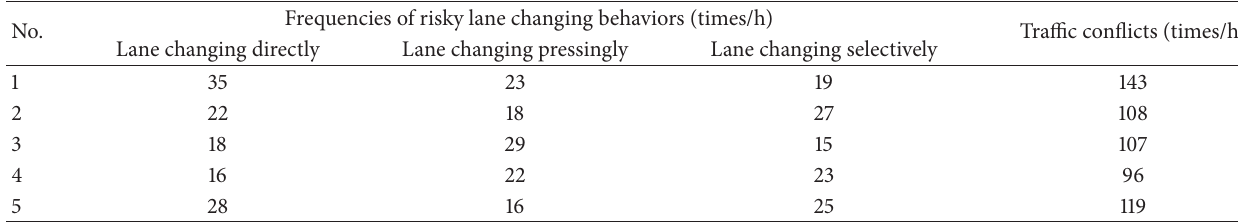
Table 9: Statistical analyses for frequencies of risky lane changing and number of traffic conflicts. No.